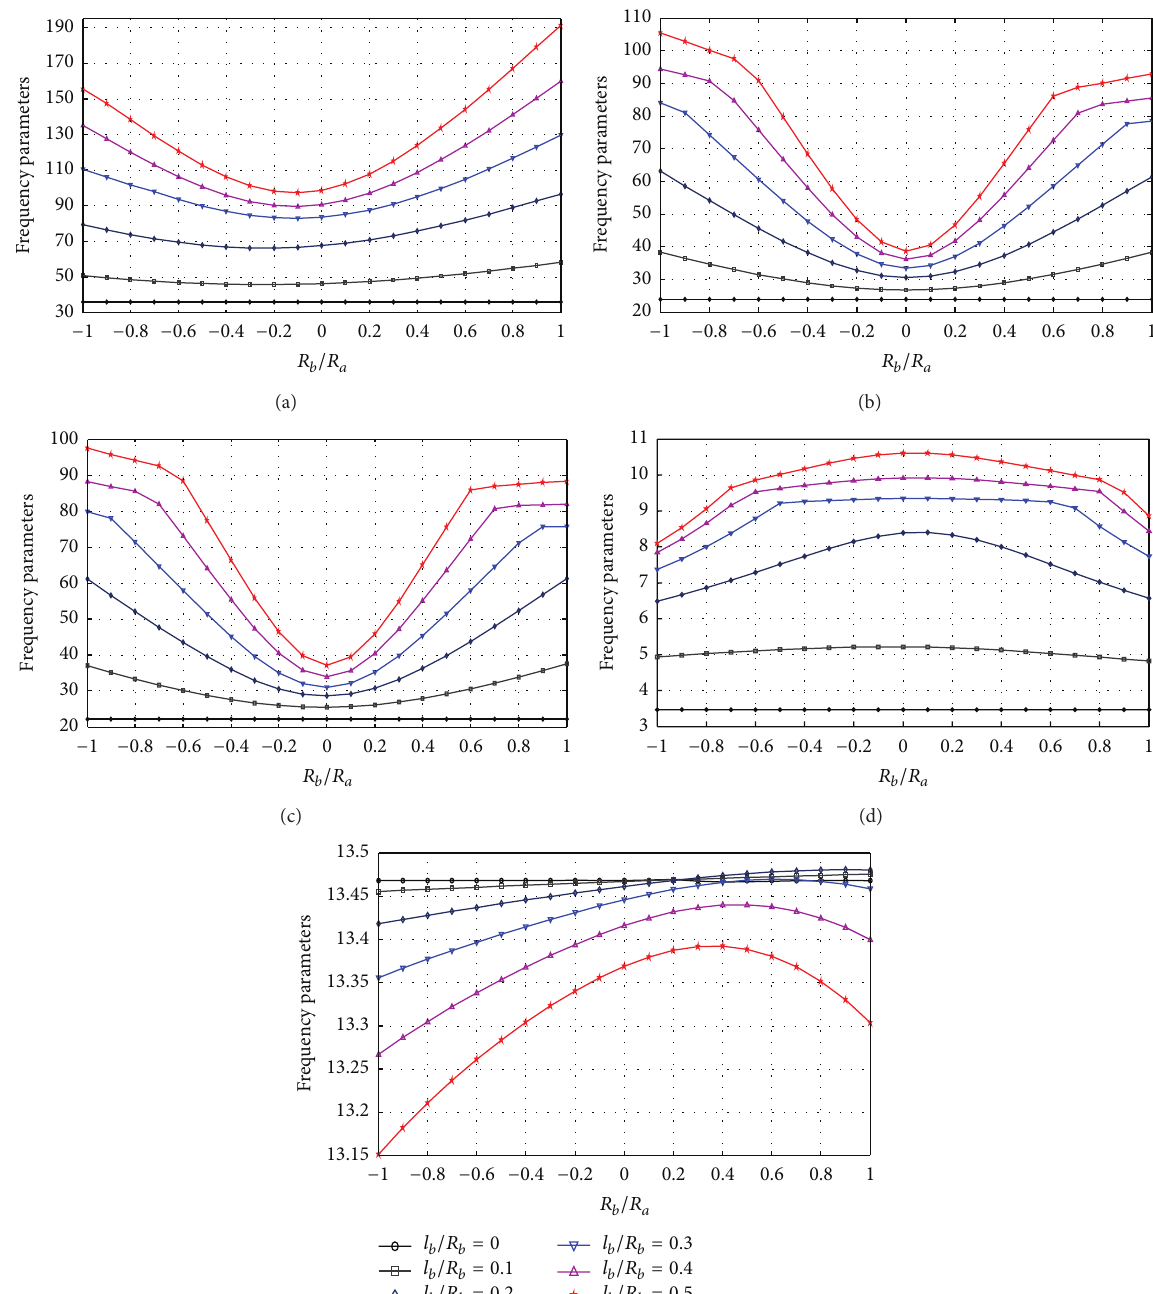
Figure 5: The first mode frequency as a function of curvature ratio for shells with different boundary conditions: (a) C-C-C-C, (b) C-C-C-F, (c) C-F-C-F, (d) C-F-F-F, and (e)